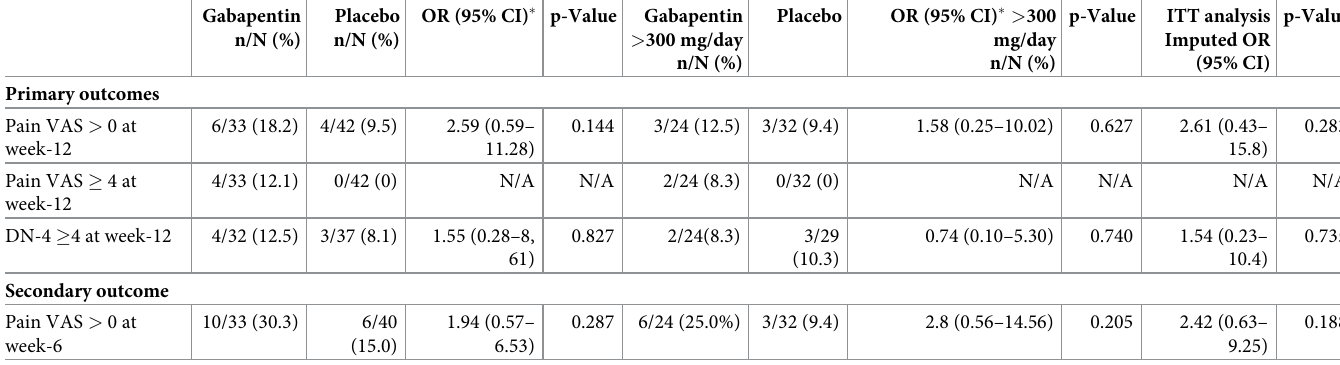
Table 2. Postherpetic neuralgia pain scores at week-12 (primary outcomes) and week-6 (secondary outcome) in the two groups. Gabapentin Placebo OR (95% CI) � p-Value n/N (%) n/N (%)